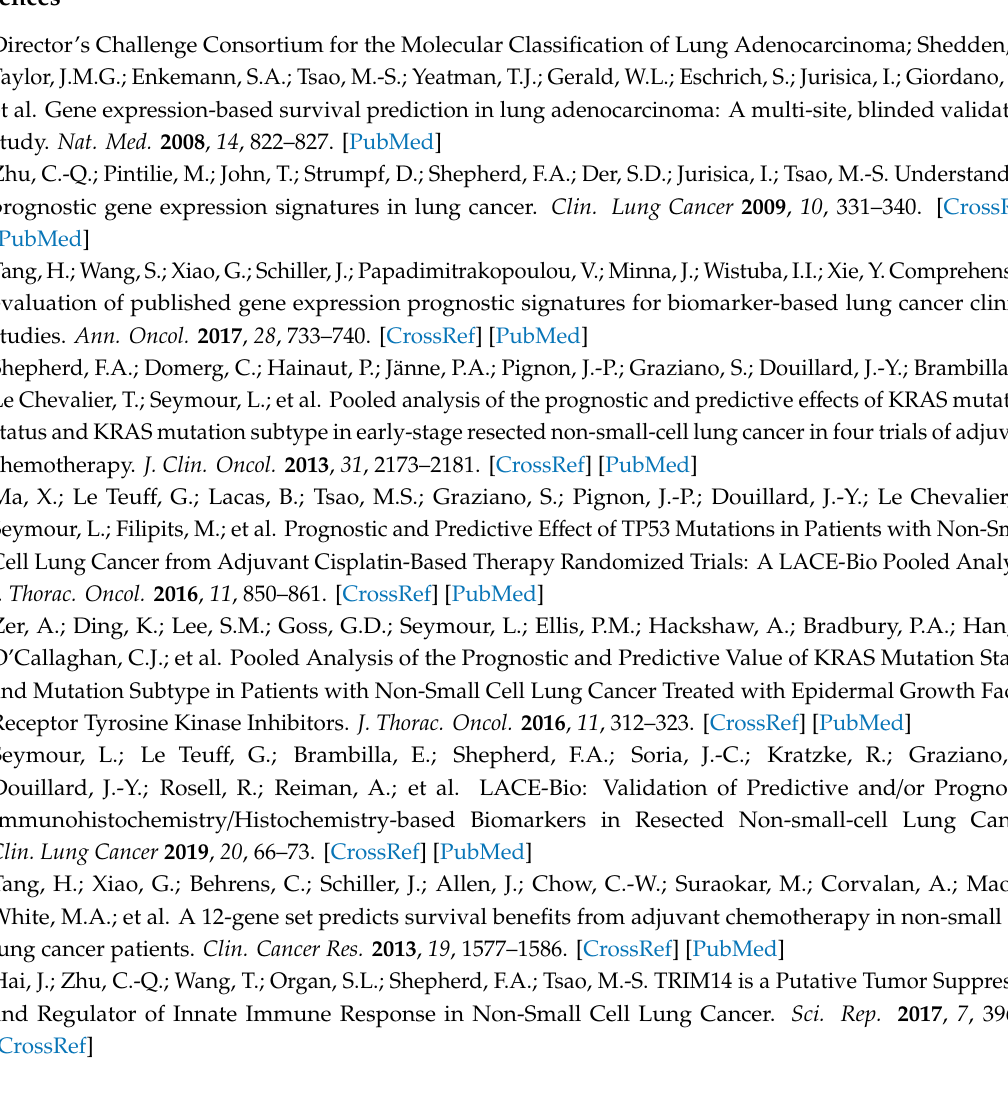
Figure S1: Association between the number of altered genes and overall survival in four independent cohorts, Figure S2: E ff ect of immunogenic peptides in stage I patients, Figure S3: Distribution of variant allele frequencies (VAFs) of missense mutations used to stratify the TCGA NSCLC stage I patients. Table S1: List of 865 genes, Table S2: Summarized clinical-pathological features of NSCLC cohorts, Table S3: List of PDX models characterized by NAG levels, Table S4: Di ff erentially-expressed genes between high and low NAG patients predictive of patient survival, Table S5: Survival analysis of neoantigens estimated from all coding mutations, Table S6: Clinical data from TCGA NSCLC stage I patients across subpopulations. Individual Excel spreadsheets contain Table S7: Comparison of mutation burden measures and their association with survival in early stage